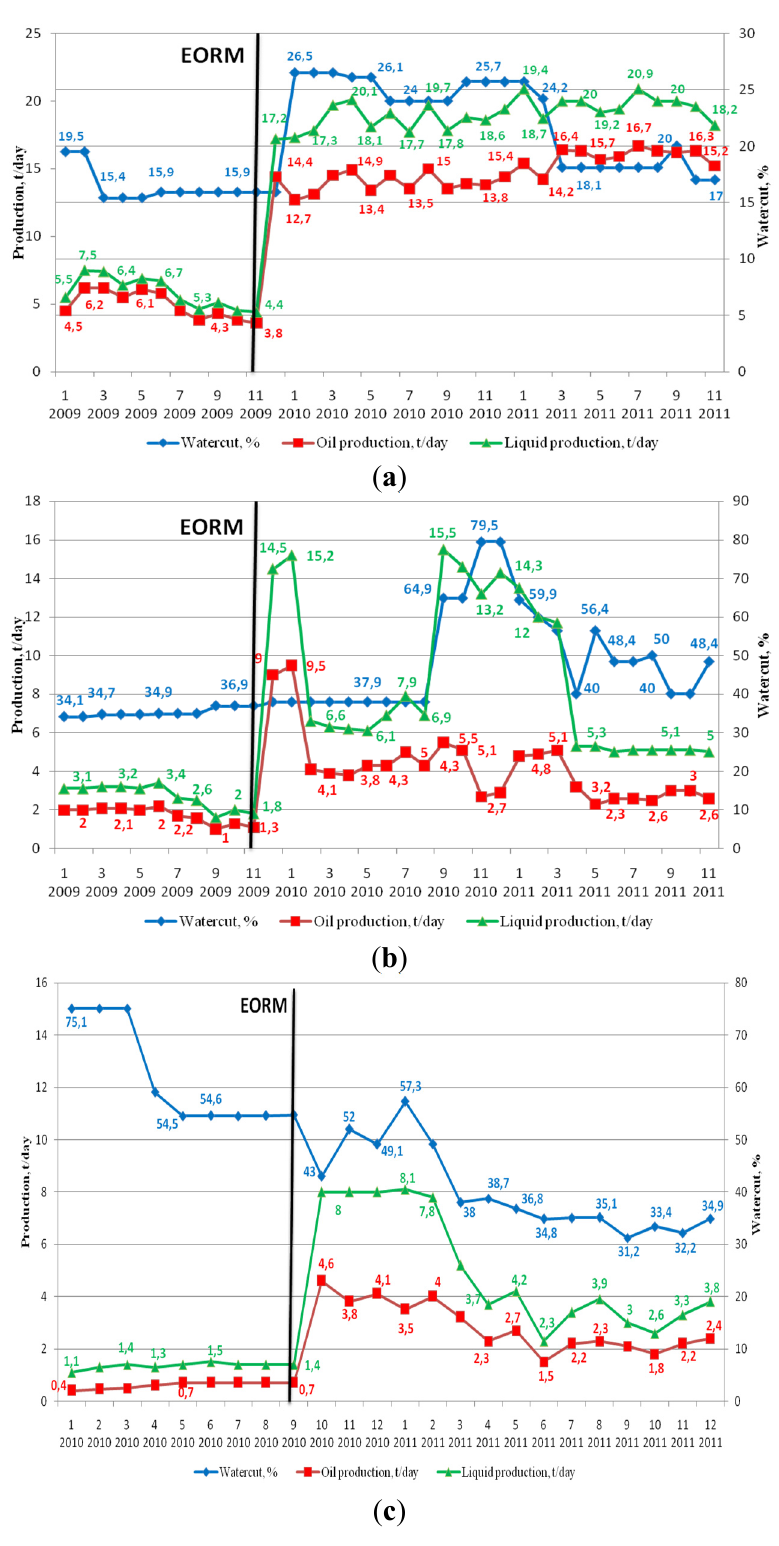
Figure 2. The dynamics of production well technological parameters, where enhanced oil recovery methods were applied: ( a ) a group of Example I wells; ( b ) a group of Example II wells; ( c ) a group of Example III